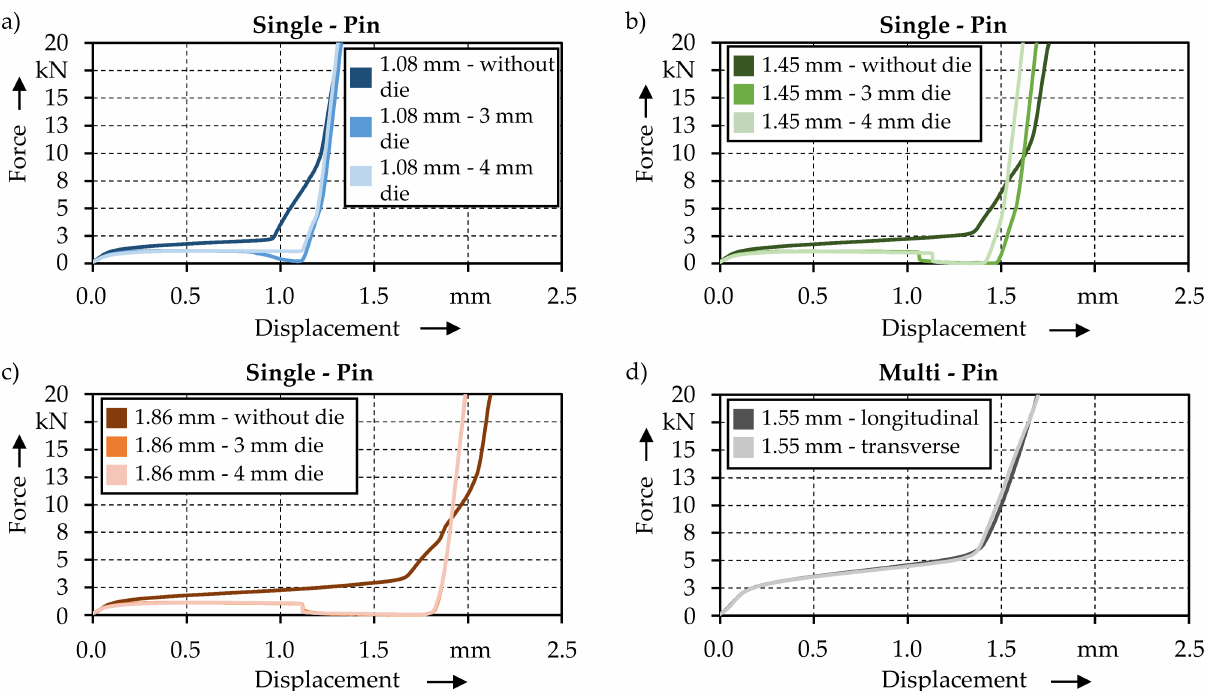
Figure 8. Force-displacement curves of the direct pin pressing joining process. ( a ) Force-displacement curves when joining 1.08 mm pins without and with die, ( b ) Force-displacement curves when joining 1.45 mm pins without and with die, ( c ) Force-displacement curves when joining 1.86 mm pins without and with die and ( d ) Force-displacement curves when joining 1.55 mm multi pin